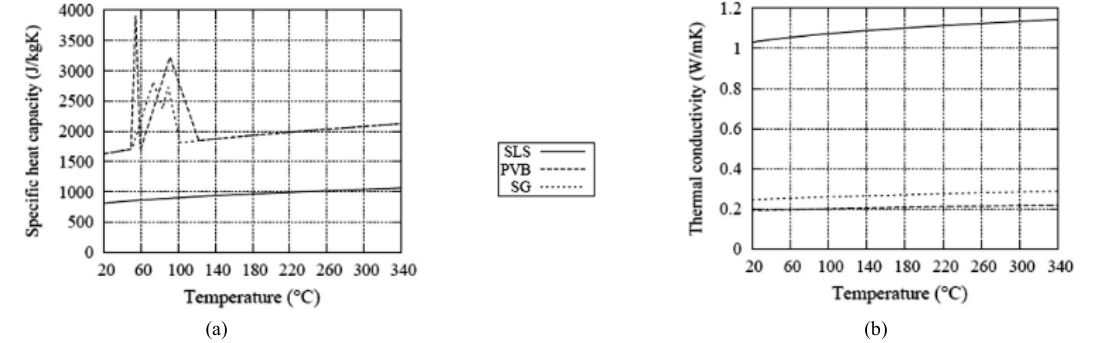
Fig. 4 AN SLS glass: Temperature dependence of (a) specific heat capacity and (b) thermal conductivity (Debuyser et al. 2017).